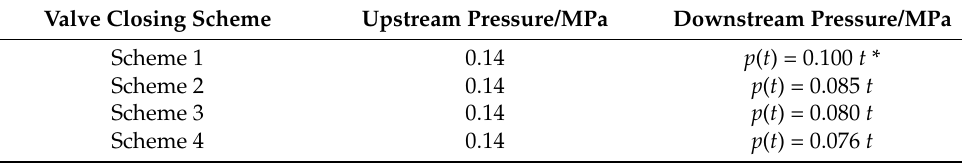
Table 2. The upstream and downstream pressure of the closing valve.